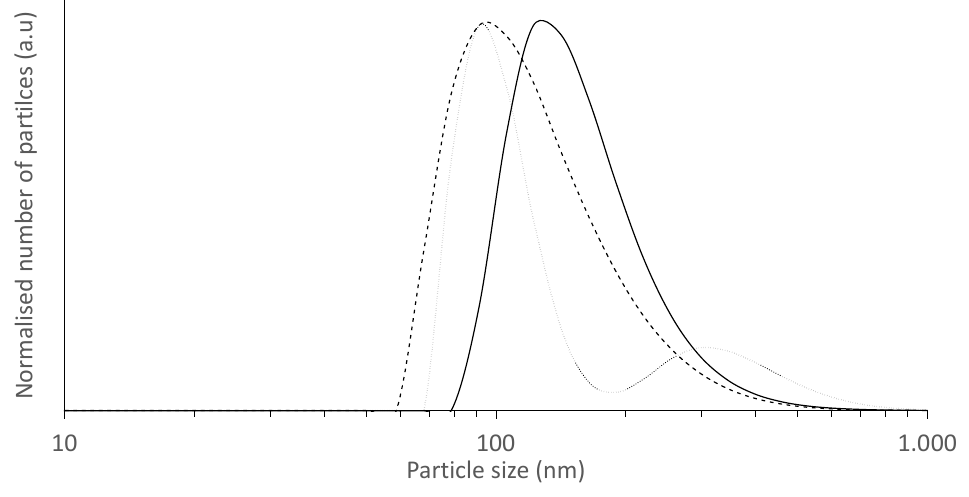
Figure 3. Dynamic light scattering spectra: B11M, straight line; B12M, dashed line; F12H, dotted